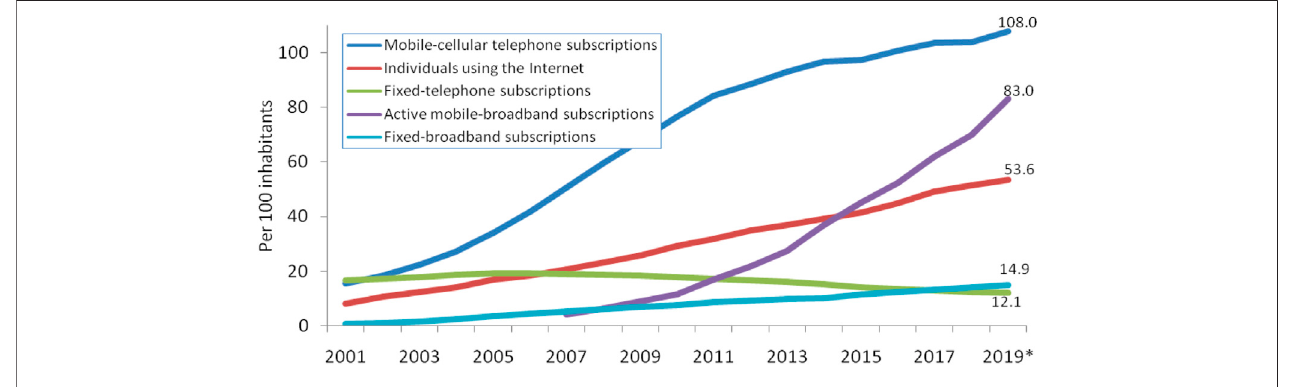
FIGURE 1 | Global ICT developments; source: ICT indicator